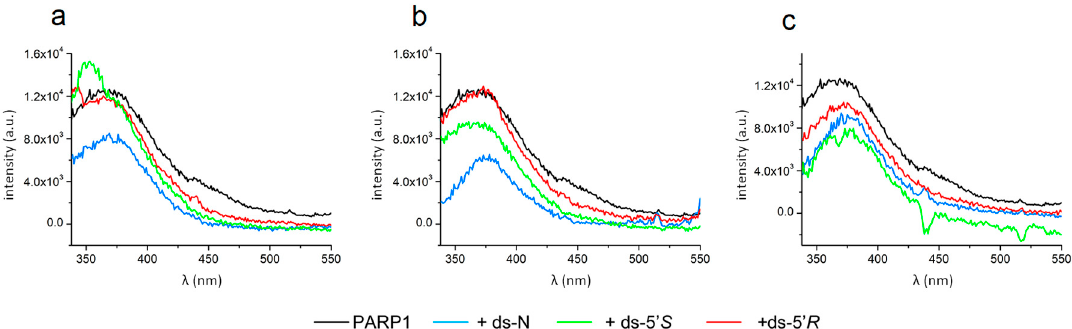
Figure 5. Intrinsic fluorescence of PARP1 in the absence and presence of DNA substrates. ( a – c ) The fluorescence profiles of PARP1 protein alone (15 µ g · mL − 1 , black line) or that of PARP1 along with 50 nM ( a ), 100 nM ( b ), and 200 nM ( c ) of ds-N (blue line) or ds-5’ S (green line) or ds-5’ R (red line).